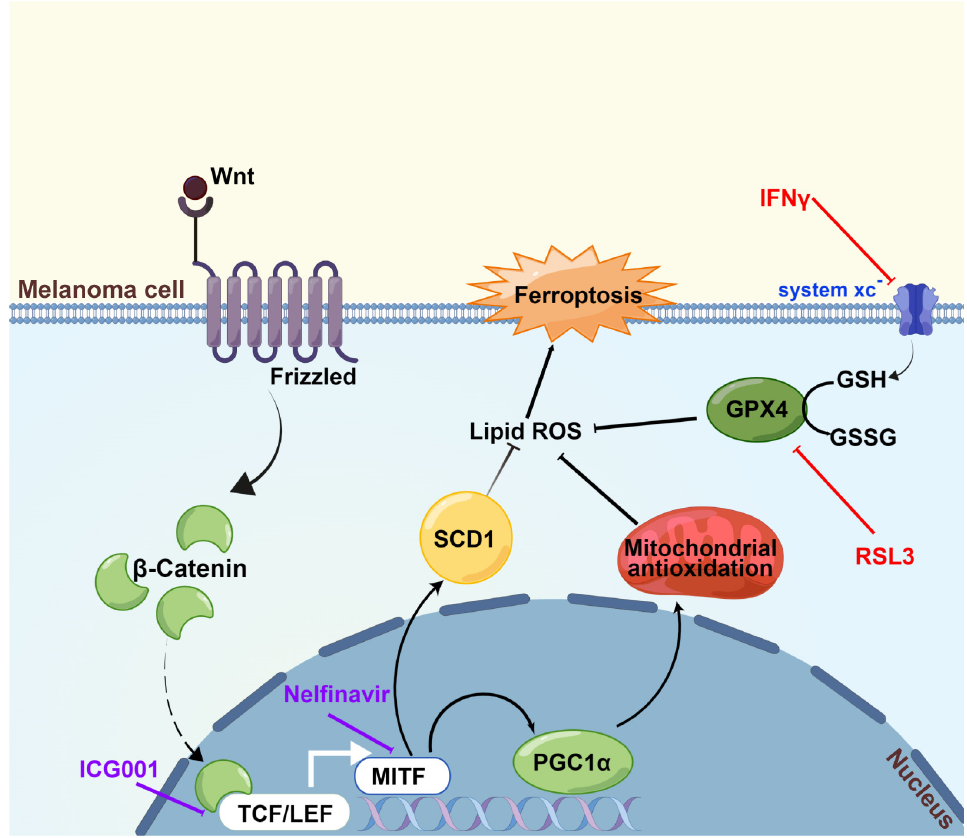
Figure 7. A proposed model of the function of the Wnt/ β -catenin-MITF pathway in ferroptosis in melanoma. The activation of Wnt/ β -catenin signaling can promote the transcription of MITF, leading to the upregulation of downstream PGC1 α and SCD1, so that the generation of lipid peroxidation is prominently suppressed and ultimately ferroptosis is inhibited. Wnt/ β -catenin signaling deficiency exacerbates ferroptosis in melanoma via the regulation of MITF. This figure was produced by Figdraw.